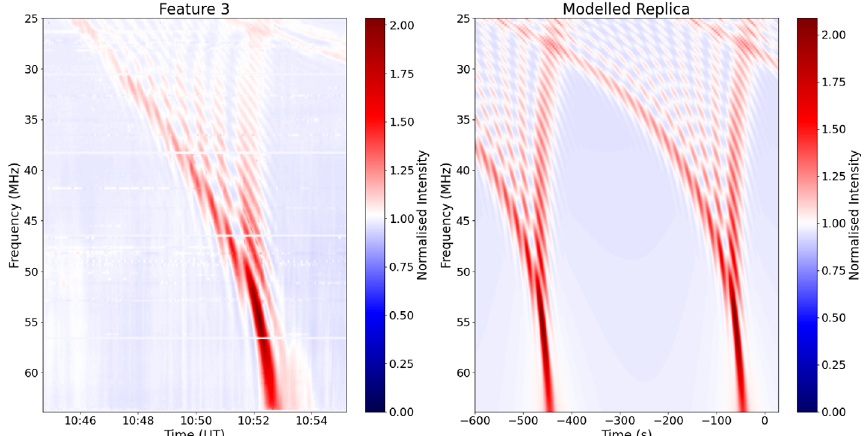
Fig. 4. Feature 3 along with its modelled replica. The time axes cover the same duration, with t = 0 in the model corresponding to the minimum electron density (i.e. the maximum of phase change) lying on the line of sight. The parameters used here are: U 0 = 8 (cid:2) 10 8 rad Hz, K = 20 km, h = 7 (cid:3) and a = 1.89 (cid:2) 10 5 rad Hz m (cid:3) 1 .